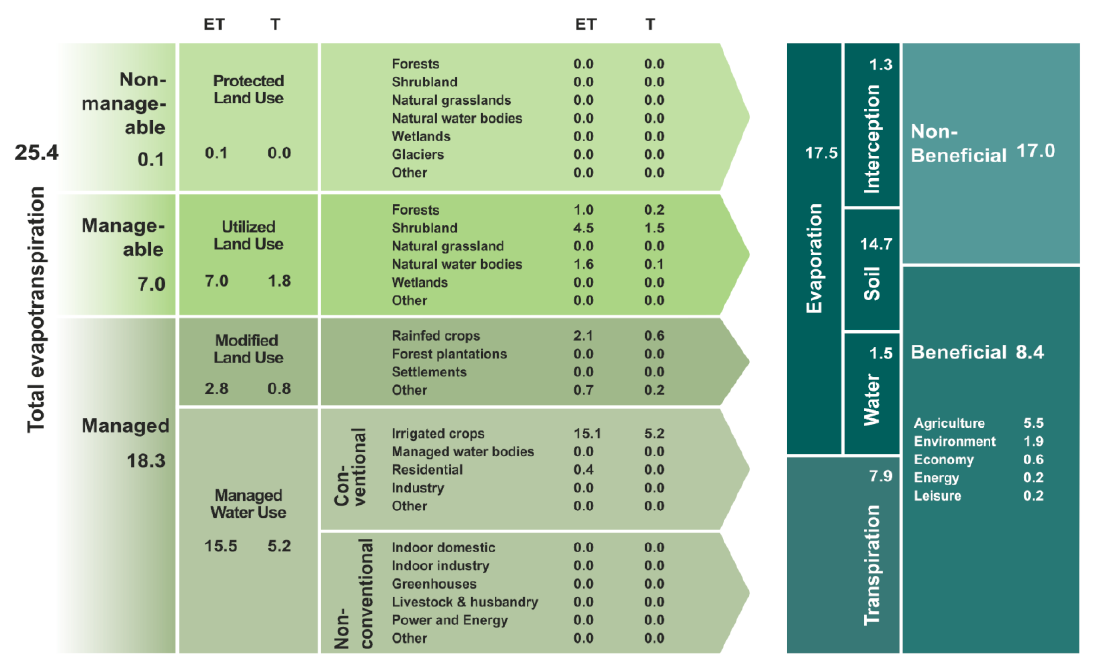
Figure 14. Sheet 2 was generated using WA+, with details of total water consumption in the basin for CHIRPS precipitation datasets, based on the dry year (2015–2016).